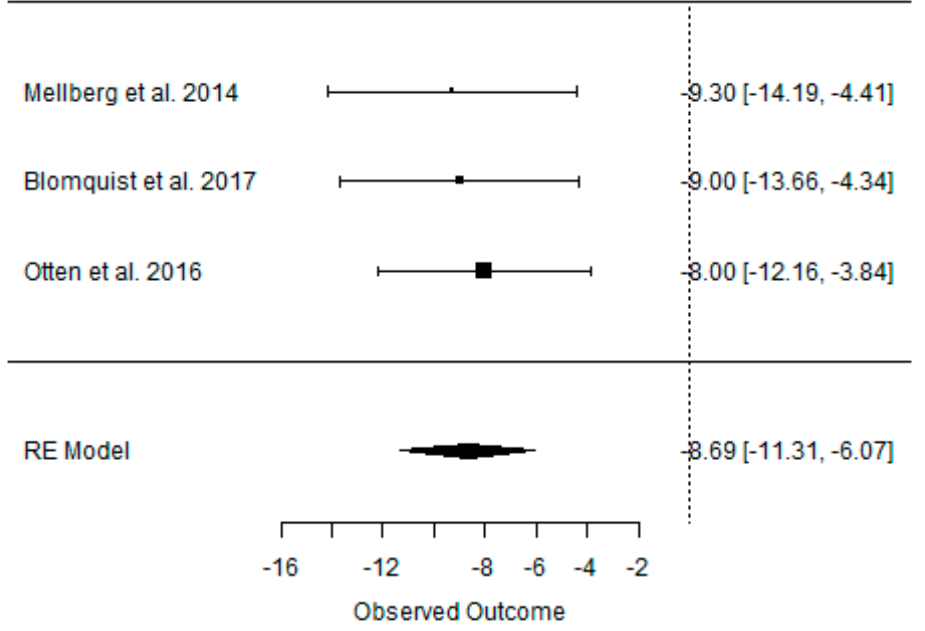
Figure A10. Forest plot of the effect of a PD on BM (kg) in the long term (weighted mean difference).